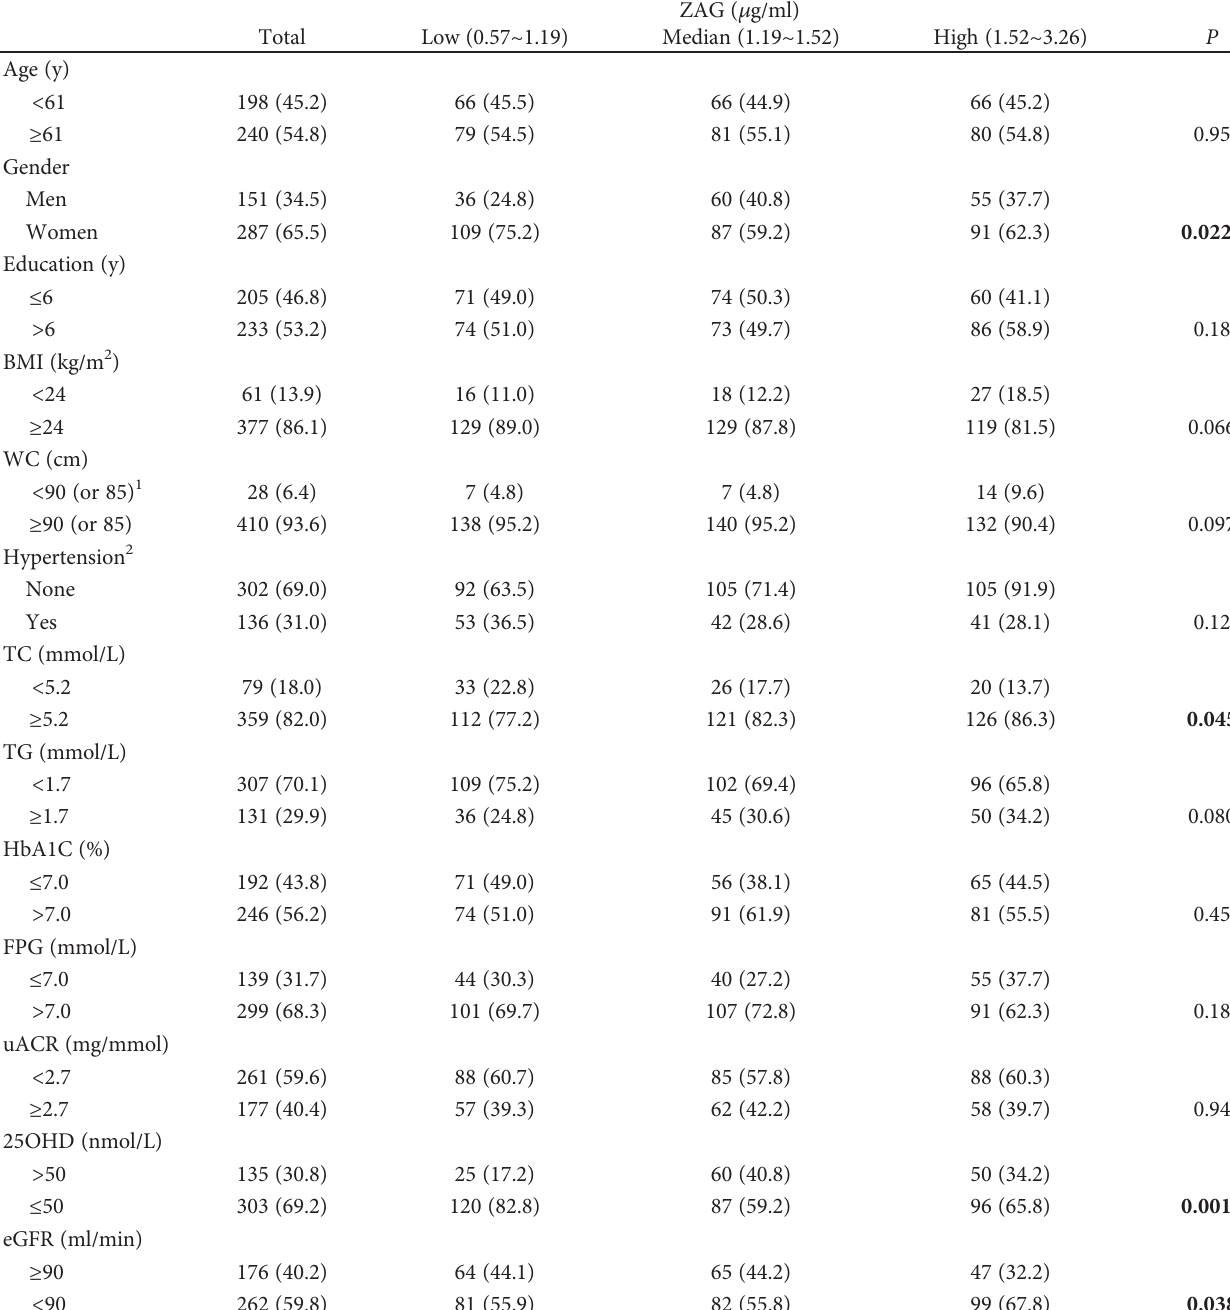
Table 2: Characteristics of T2DM patients with the low, middle, and high serum ZAG